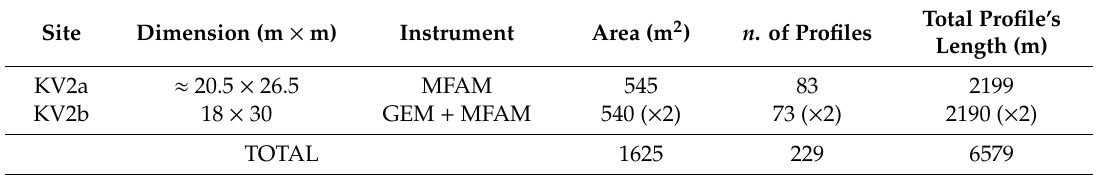
Table 7. Details concerning the extension of the MAG-3 and MAG-2 surveyed area.